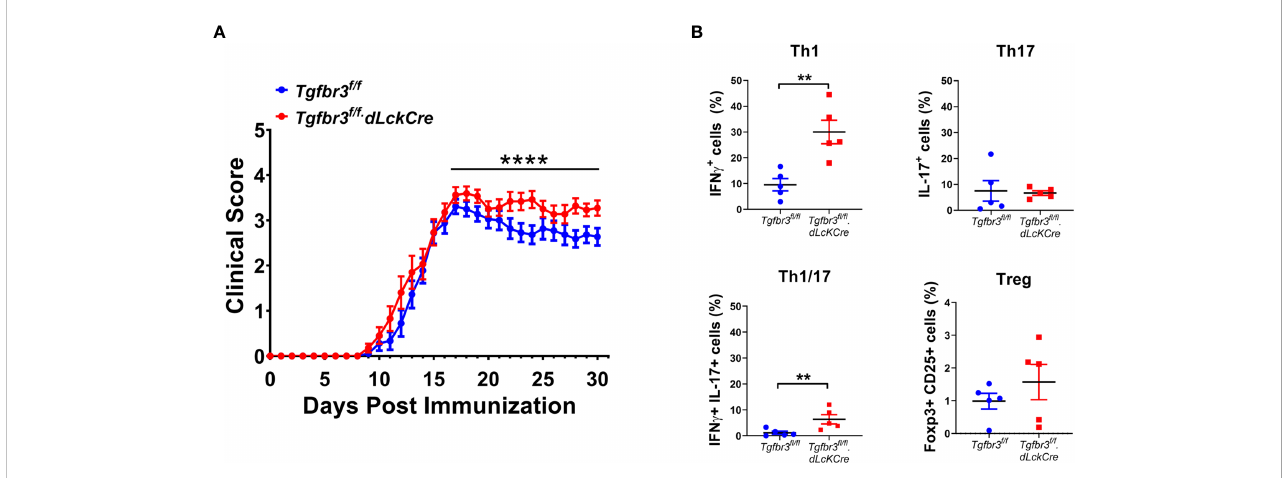
FIGURE 3 T cell speci fi c T b RIII null mice develop more severe EAE after immunization with MOG 35-55 . (A) EAE clinical score of Tgfbr3 fl / fl .dLcKCre (red, N=20) and Tgfbr3 fl / fl (blue, n=18) mice immunized with MOG 35-55 peptide in CFA. (B) Th17, Th1, Th17/1 and Treg cells in spinal cord of Tgfbr3 fl / fl dLcKCre (red) and Tgfbr3 fl / fl (blue) mice at peak of disease. Littermate mice were immunized with 150 µg MOG 35-55 peptide in CFA and clinical course of disease was determined. Mice with an EAE clinical score above 4 or a drop in weight of over 20%, mice were humanely euthanized. After a mouse was euthanized, it ceased to be scored and was therefore removed from future analysis. In (B) each dot represents an individual mouse. Data is mean ± SEM; Non- parametric t-test for (A) and parametric t-test for (B) . **=p<0.01,,